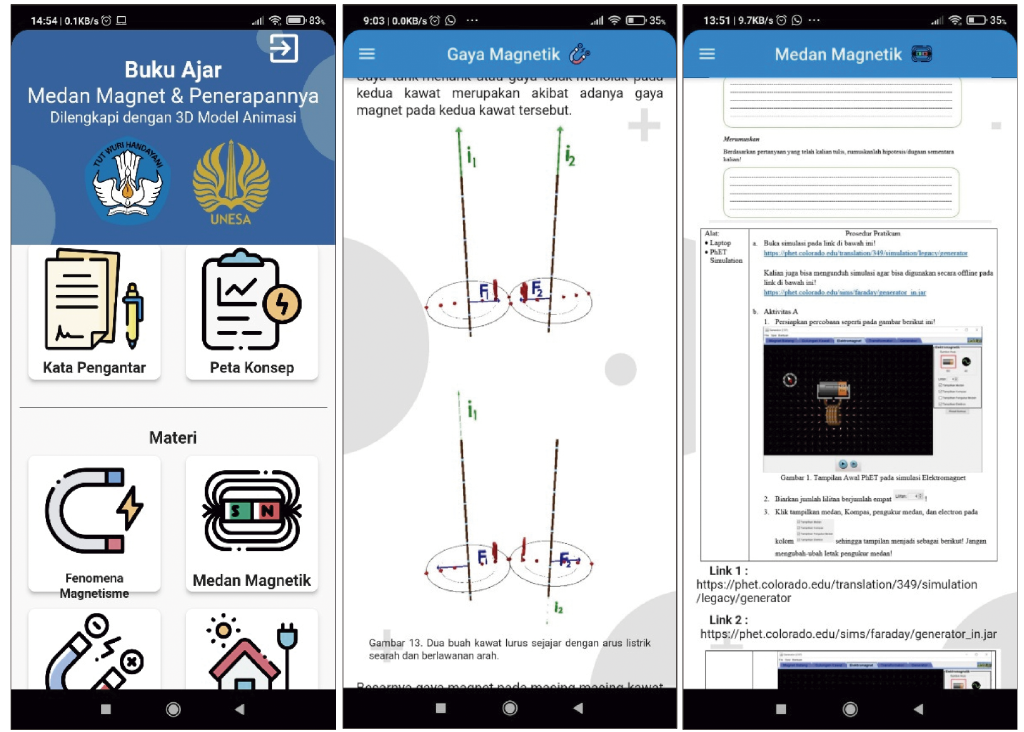
Figure 2. Some screenshots of digital book products with 3D animation (Source: